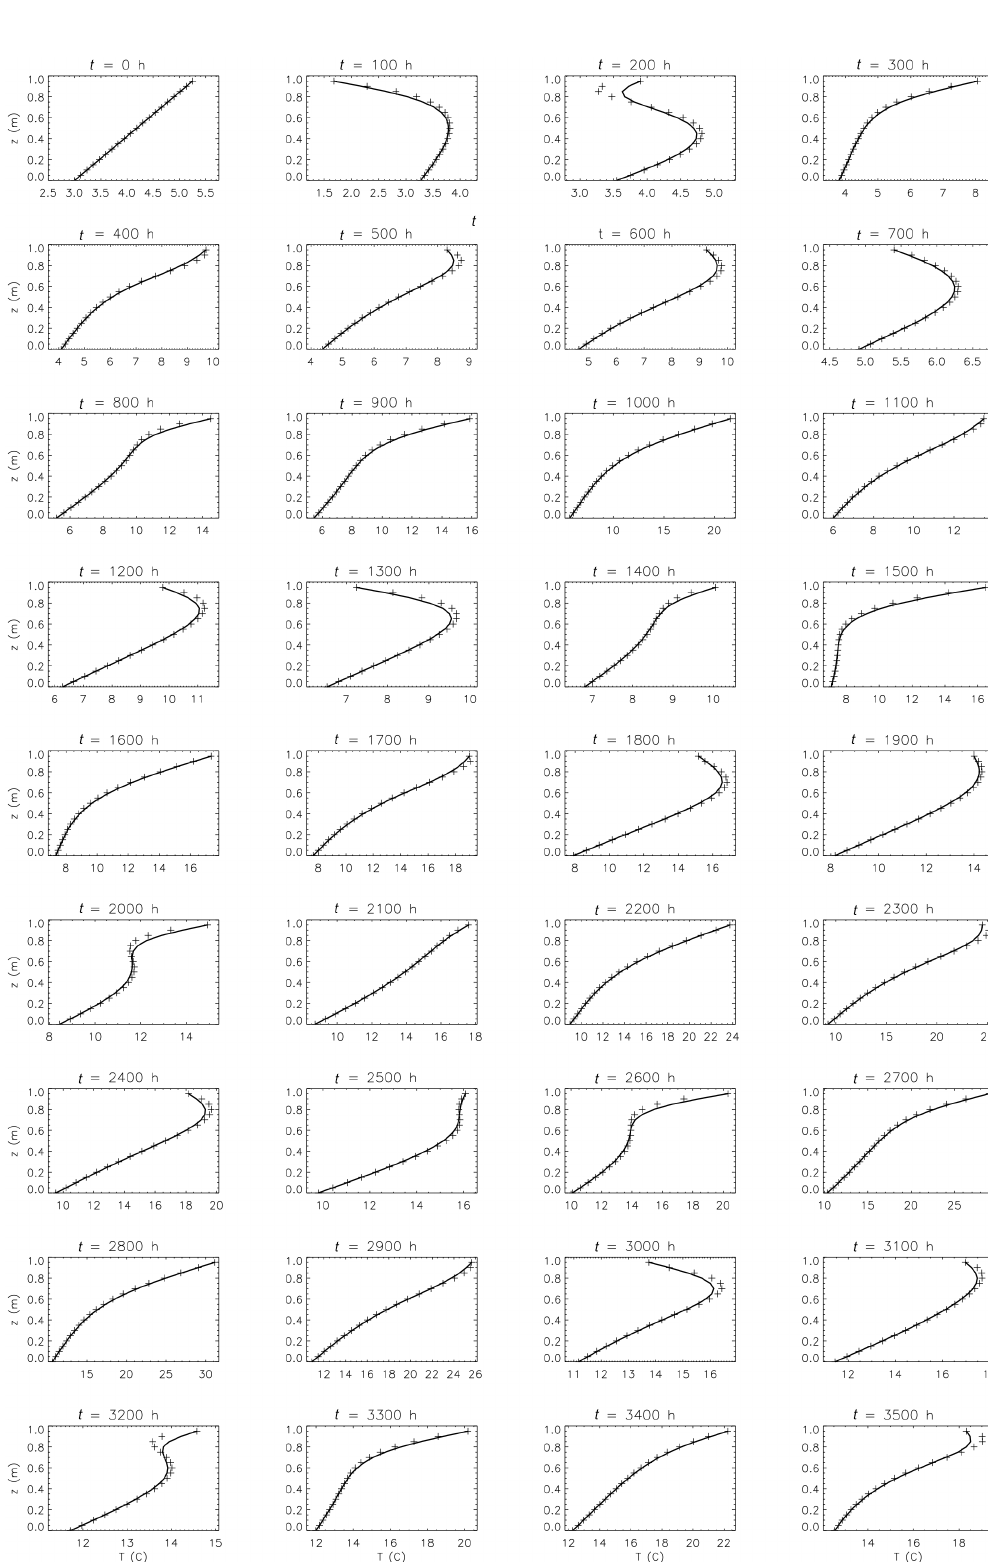
Figure 4. Comparison between soil temperature profiles obtained using the numerical ( + ) and analytical (solid line) solutions for coarse spatial and temporal